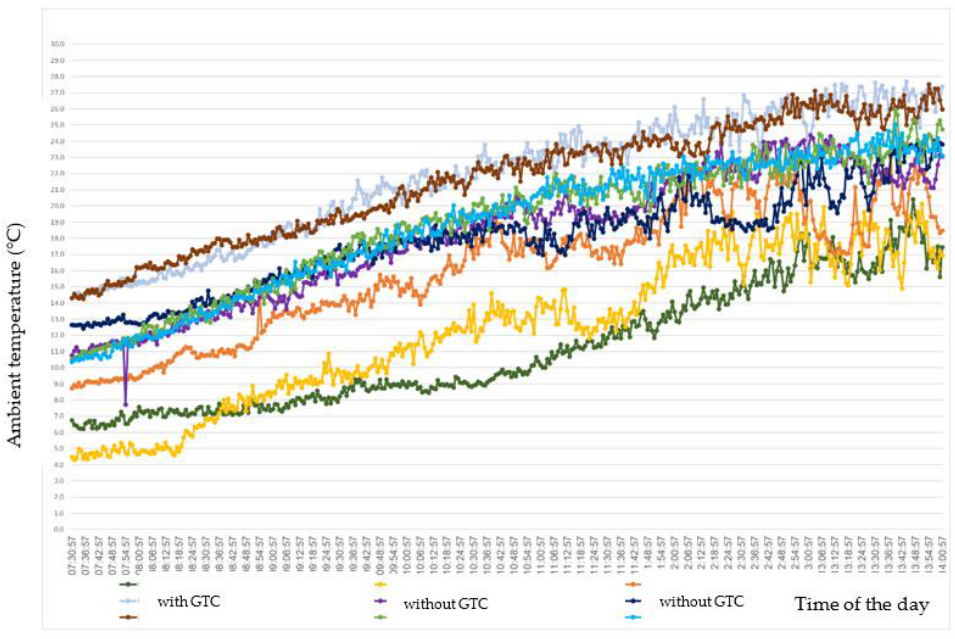
Figure 12. Outdoor temperature for several days during the experimental tests.